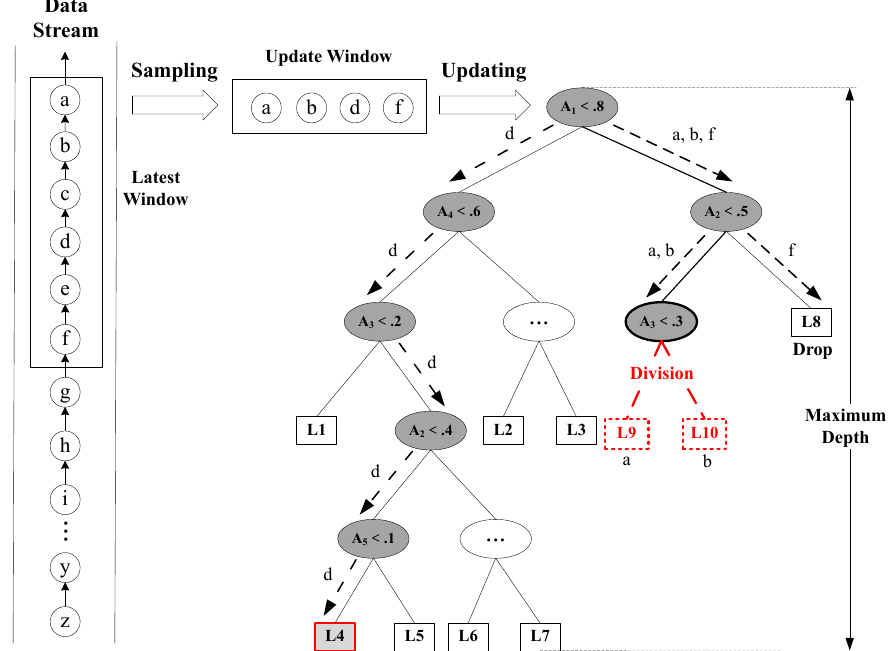
Figure 2. An example of a single tree growing online. Data points a , b , d , f are sampled from normal instances in the sliding window. They are input into a random binary tree, and then traverse the branch from the root node to find the corresponding leaf nodes. The rectangle represents the leaf node and the ellipse represents the branch node, in which the split attribute and split value constitute the division condition. i ) a and b should have fallen into the sibling of L 8, but because the leaf node does not reach the maximum depth, this node needs to split (assuming that the split probability of the node satisfies the condition and the node changes from a leaf to a branch) and create two new leaf nodes L 9 and L 10 (dotted rectangle), which record a and b , respectively; ii ) f falls into L 8 and it overlaps with the data recorded in L 8, then drops it; iii ) d falls into L 4, which reaches the maximum depth, and the number of data recorded in L 4 will be